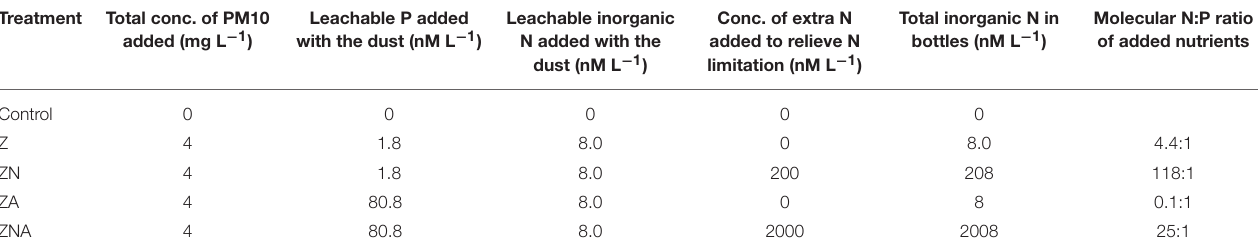
TABLE 1 | Concentration of leachable nutrients (inorganic P and inorganic N) added to each one of triplicate sets of microcosms (treatments). Treatment Total conc. of PM10 added (mg L − 1